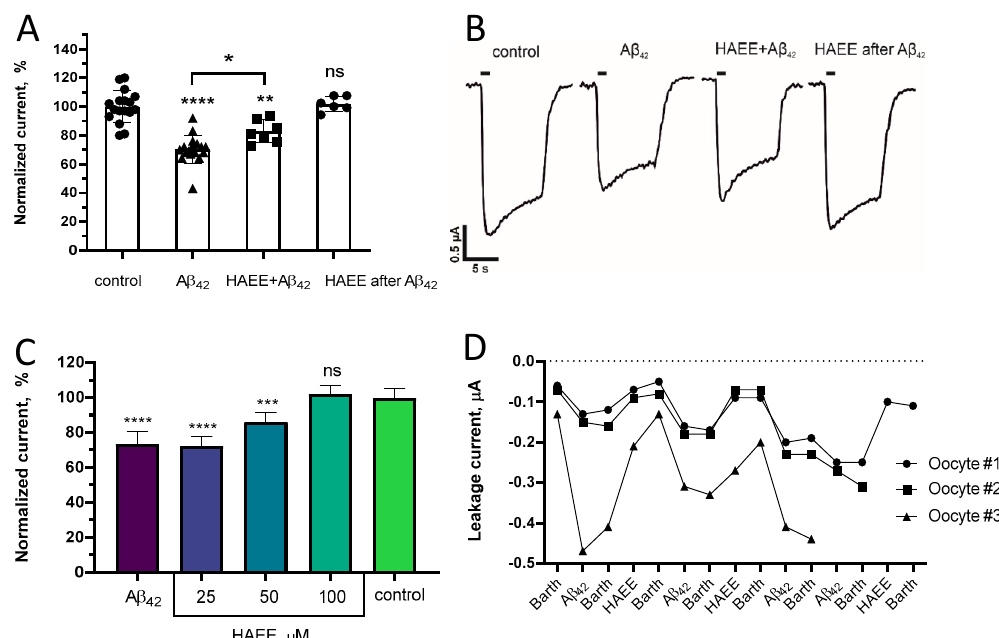
Figure 5. ( A ) Representative ion current traces and ( B ) normalized amplitudes of ACh (100 µ